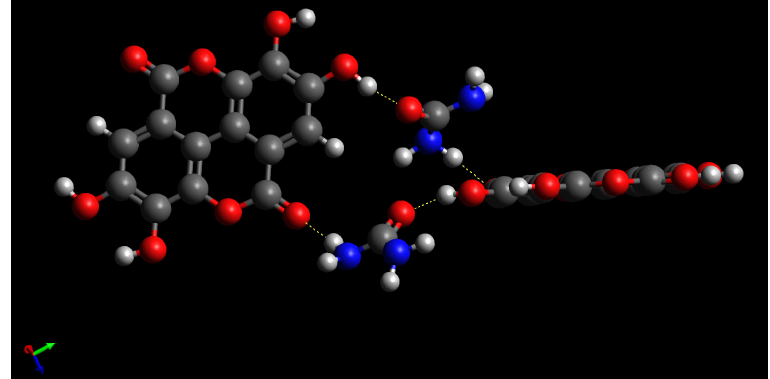
Figure 10. NOESY NMR spectra of EA/UR systems in DMSO-d6. ( a ) f1, 0–12 ppm; f2, 0–12 ppm ( X